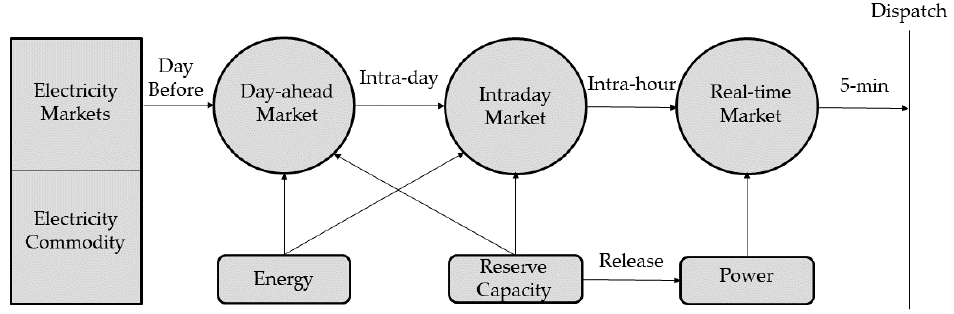
Figure 2. The existing deregulated market design [16].